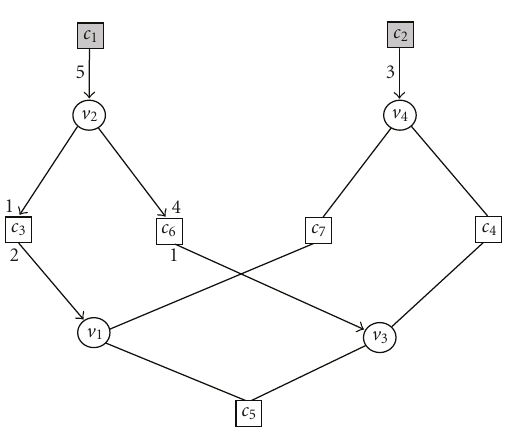
Figure 6: Tree structure for the trapping set T